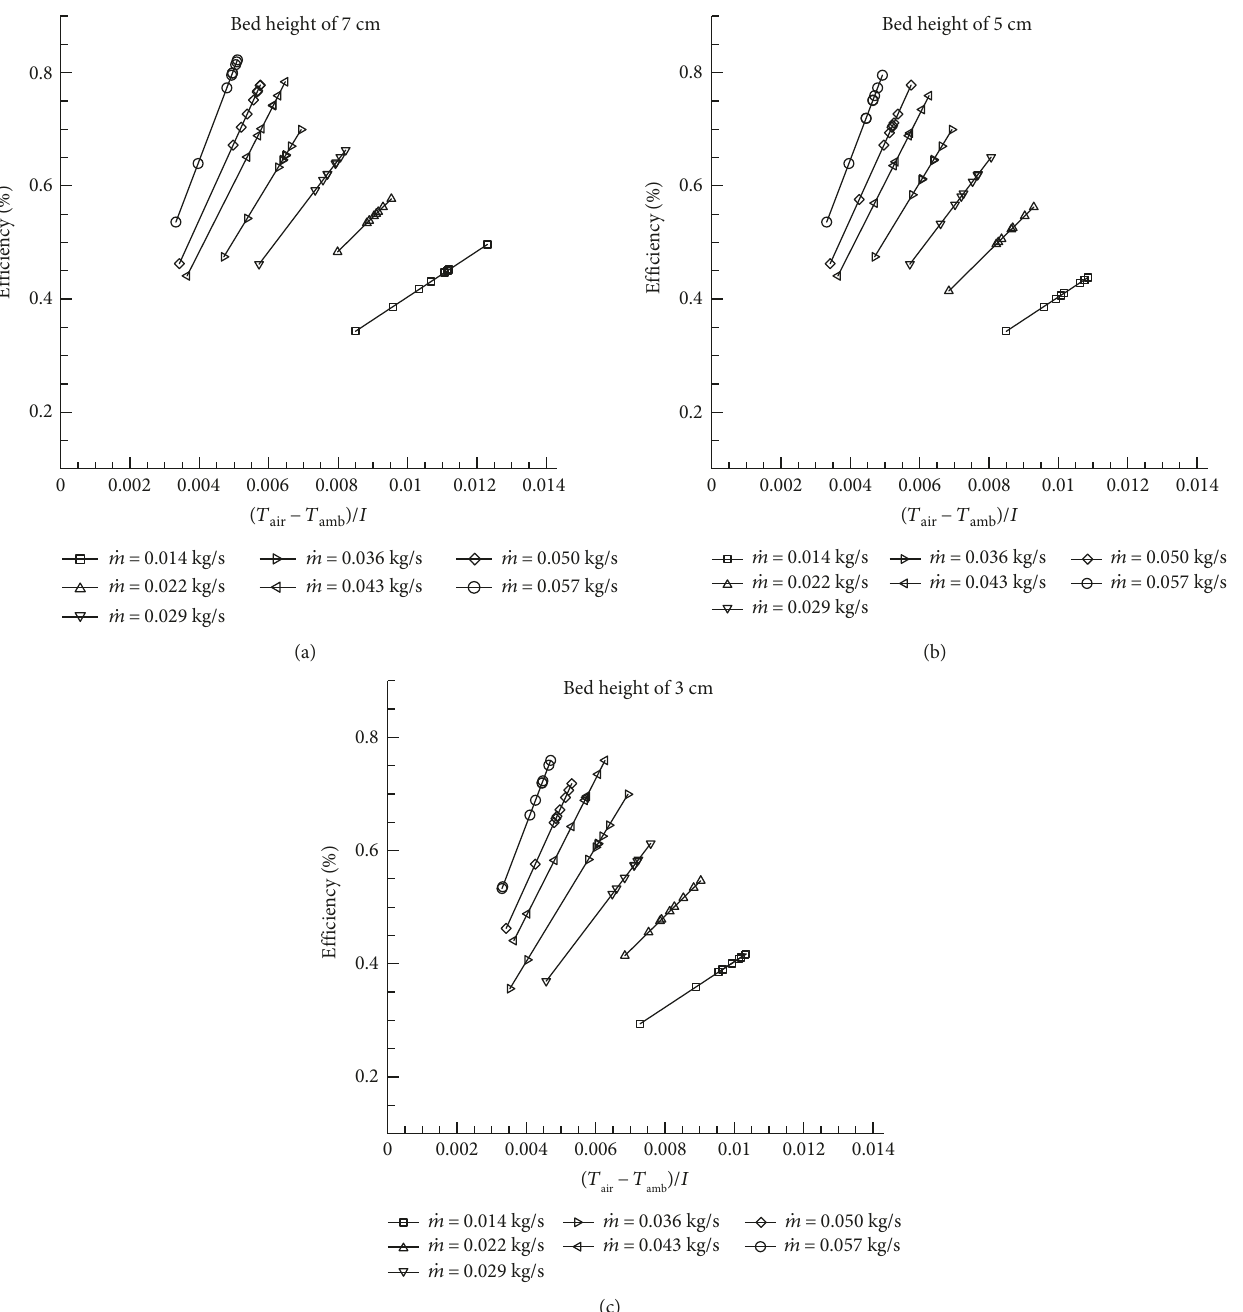
− T / I at a gap distance of 0.5mm and di ff erent mass fl uxes for SGSAHs with varying bed heights air amb